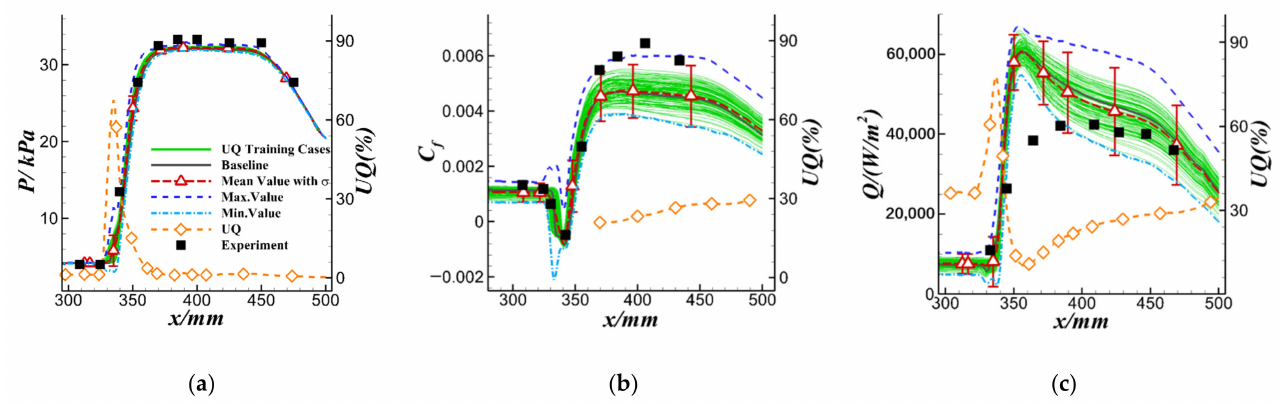
Figure 9. Distribution of the wall properties with uncertainty analysis results for θ = 10 ◦ case. ( a ) Wall pressure; ( b ) skin friction; ( c ) wall heat flux.